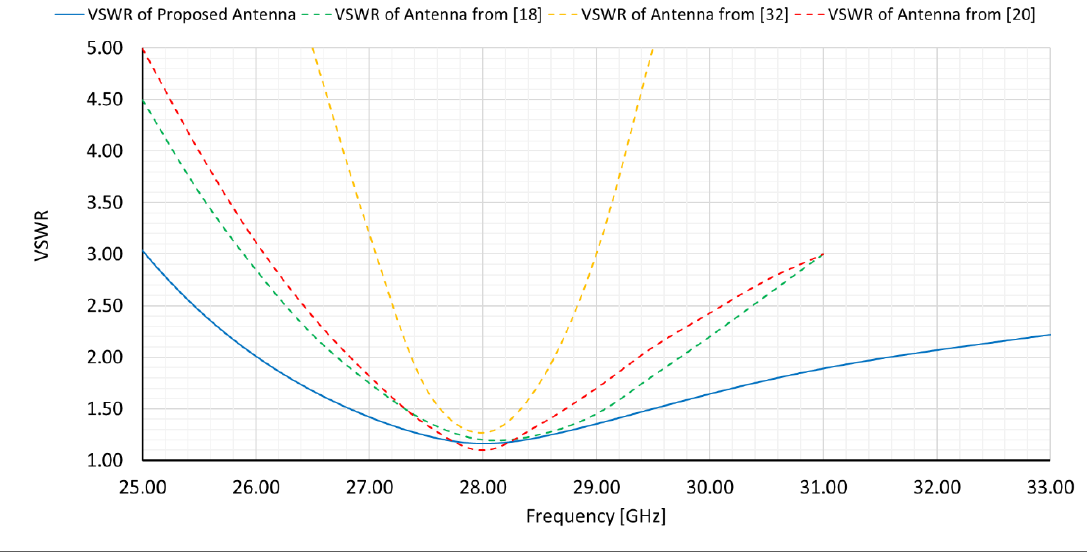
Table 3. Comparisons among the bandwidth achieved in the present work to those achieved in other published works.